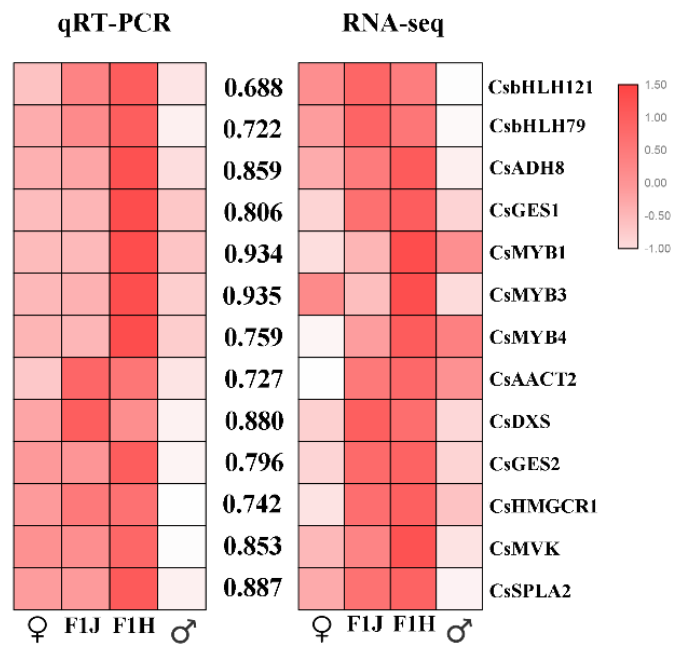
Figure 8. Correlation analysis of candidate genes. The values between the two heatmaps represent correlation value between the expression profiles obtained from RNA-seq and RT-qPCR analysis for each gene. The heatmap drawing was conducted by correlation between genes analyzed by the Spearman test using SPSS 17.0 software and visualized by the TBtools software. “ ♂ ” means male parent; “ ♀ ” means female parent; “ F1J ” means JGY; “ F1H ” means HGY.